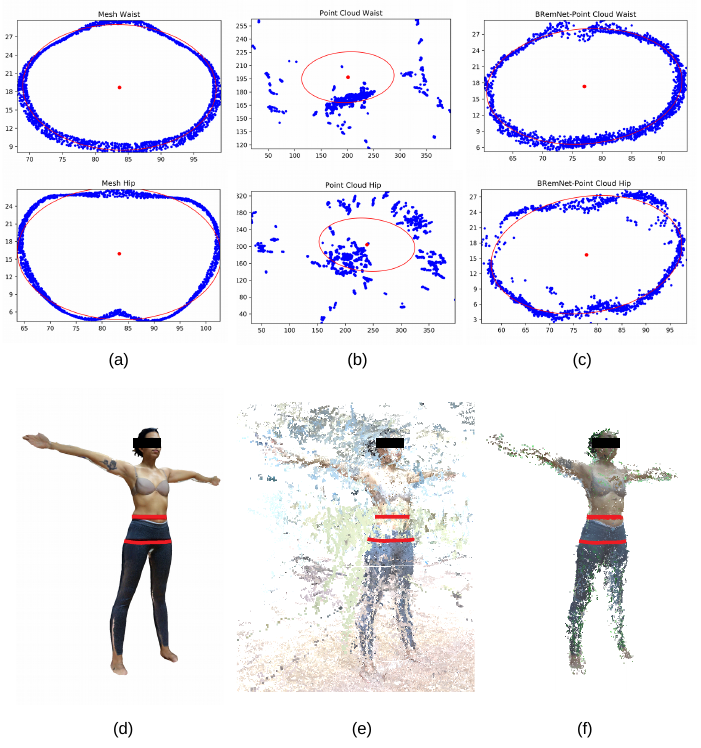
Figure 8. Waist and hip approximation. ( a , d ) LiDAR-based mesh, ( b , e ) Unsegmented point cloud (scale 1:6), ( c , f ) BRemNet -segmented point